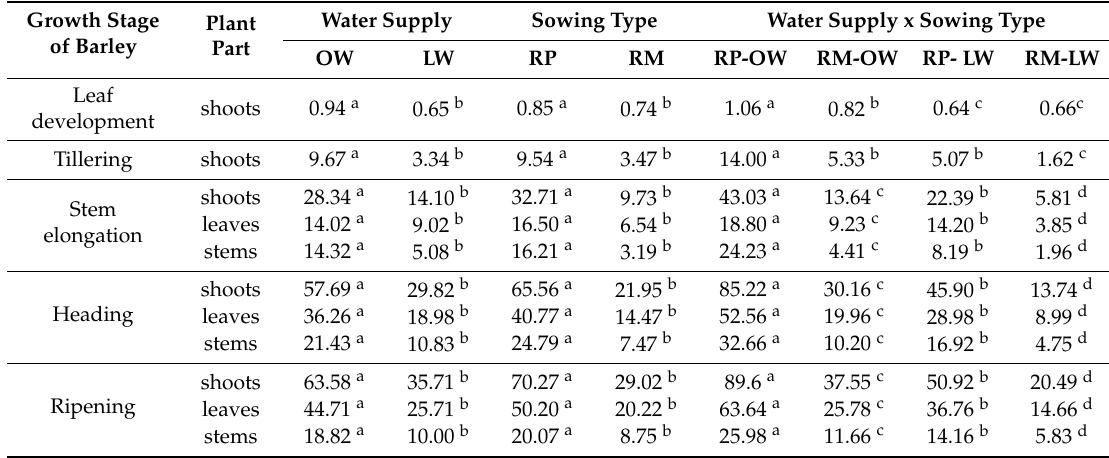
Table 3. Phosphorus accumulation by rye-grass (mg pot − 1